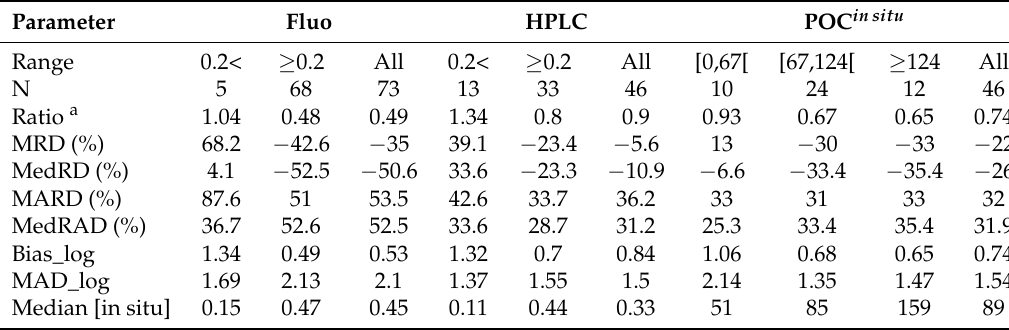
Table 3. Statistics of the comparison between satellite and in situ values for different ranges in concentration. A time window of 12 h and box 1 was used for the extraction